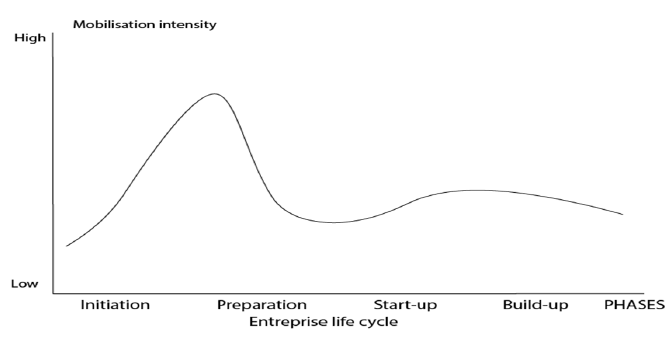
Figure 3. Mobilization of family and other networks.